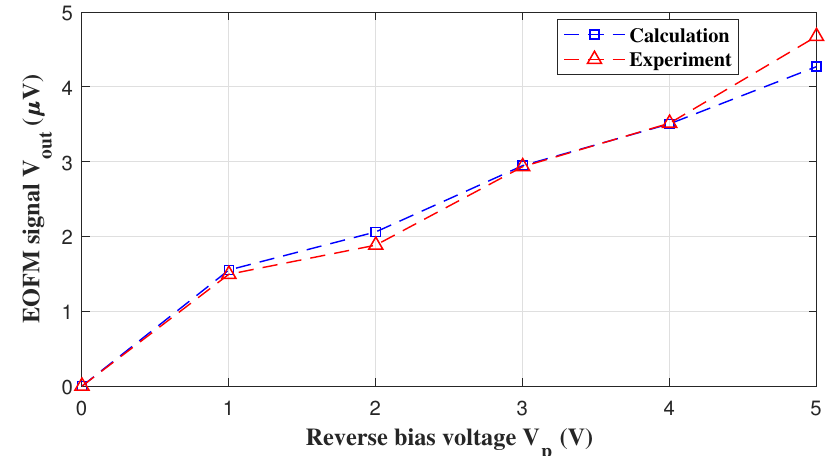
Figure 9. EOFM signal level obtained by calculation and